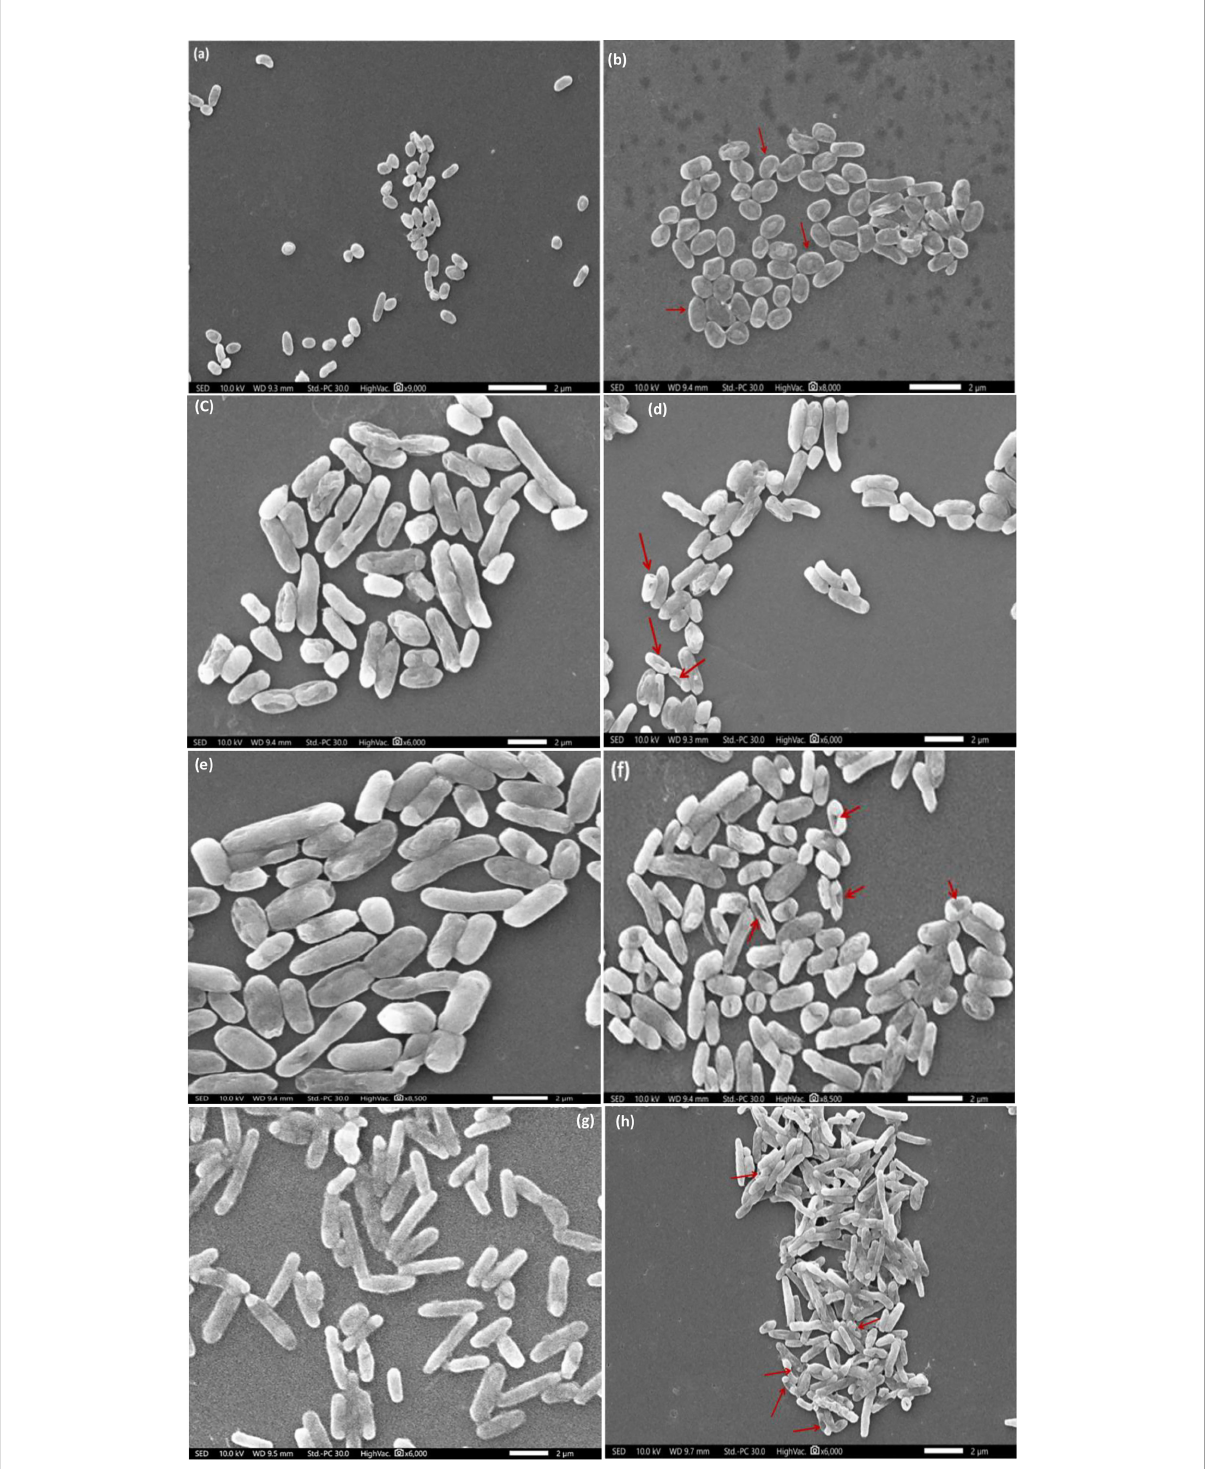
FIGURE 6 SEM analysis showing Hg effect on bacterial cells: (A, B) NIOT-EQR_J7, (C, D) NIOT-EQR_J248, (E, F) NIOT-EQR_J251 and (G, H) NIOT- EQR_J258. Images were taken in the presence of different concentrations of Hg 2+ : ( A, C, E, G - Control; B, D, F, H - 100 mg/L). The red arrow shows the structural